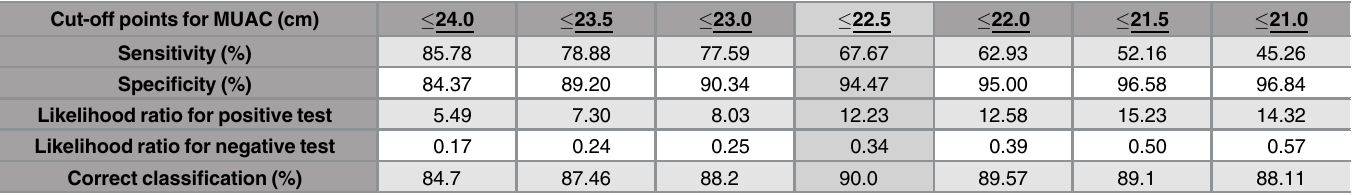
Table 2. Diagnostic validity of Mid-Upper Arm Circunference for the detection of malnutricion (Body Mass Index < 18,5 kg/m 2 ). Cut-off points for MUAC (cm) (cid:1)